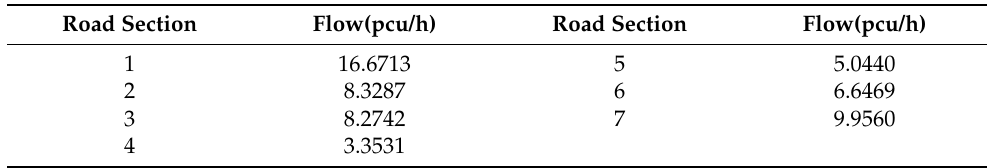
Table 8. Equilibrium solution of state 7 without optimized.